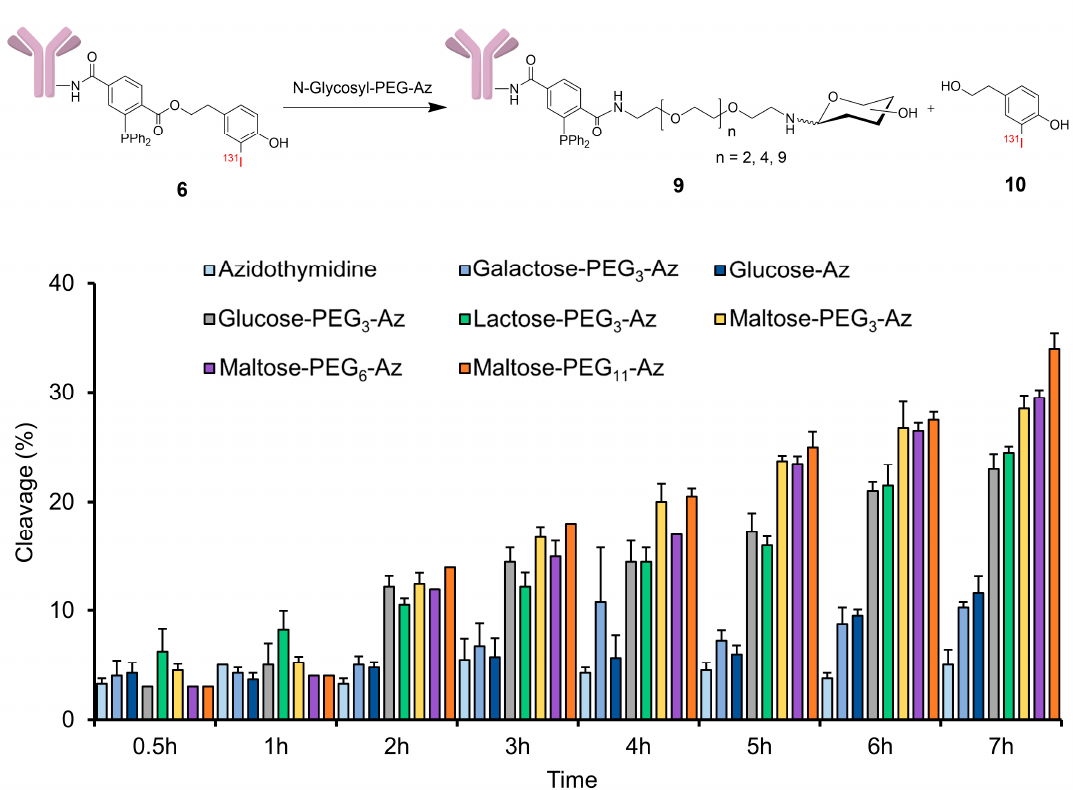
Figure 5. The reaction between [ 131 I]DPTA-trastuzumab ( 6 ) and N-glycosyl azides led to the elimina- tion of radioactivity ( A ). Graph representing the cleavage observed at the corresponding time points (n = 4) ( B ).